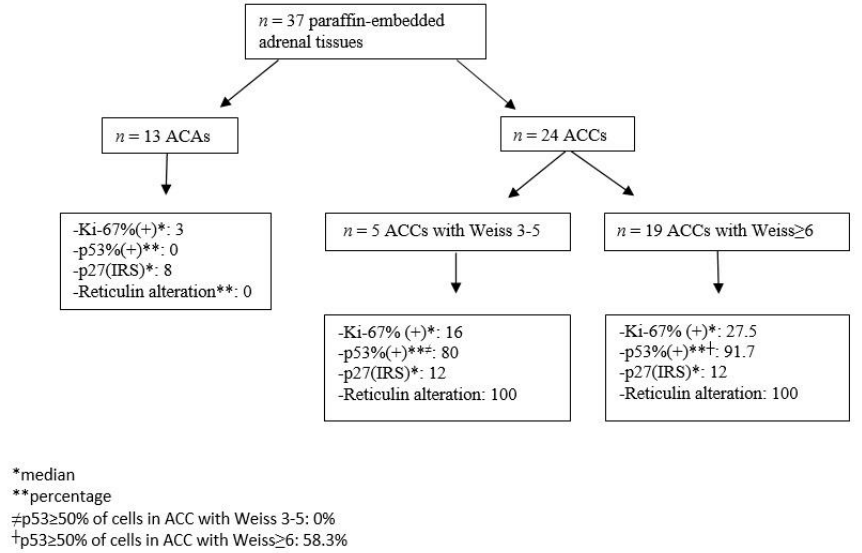
Figure 2. Expression of the Ki-67%, p53, p27 immunohistochemical nuclear markers as well as reticulin expression in adrenocortical neoplasms. All ACA cases exhibited Ki-67% labeling index ≤ 5% (median: 3%) and expressed the wild type p53 expression. No altered reticulin pattern was observed and median IRIS of p27% staining was 8. In all ACC cases Weiss was higher than 3, with altered reticulin pattern and similar IRS of p27 staining. However, those with relatively lower Weiss 3–5, exhibited lower median Ki-67% labeling index and p53 staining compared with ACC cases with Weiss scores greater than 6. Abbreviations: ACA: adrenocortical adenoma; ACC: adrenal cortical carcinoma; IRS: immunoreactive score; WT: wild type